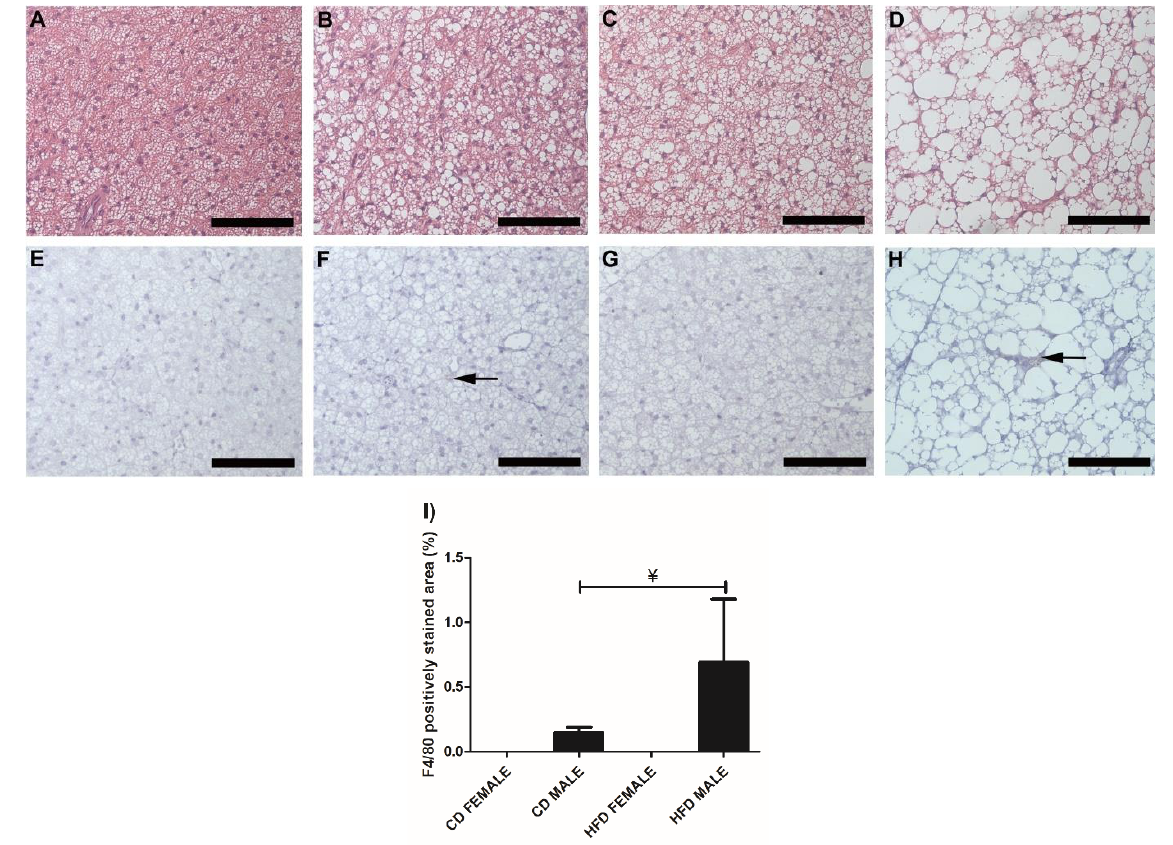
Figure 4. Histology and immunohistochemistry of BAT. Histological sections showing adipocytes in BAT of CD females, ( A ); CD males, ( B ); HFD females, ( C ); and HFD males, ( D ). Adipocyte expansion was evident in the HFD males, ( D ) and females, ( C ) compared to the CD males, ( B ) and females, ( A ). F4/80+ immunostained sections from CD females, ( E ); CD males, ( F ); HFD females, ( G ); and HFD males, ( H ). Macrophage infiltration (black arrow) was only evident in males on CD, ( F ) and HFD, ( H ) with the HFD males displaying a significantly greater extent of macrophage infiltration, ( I ). No macrophages were observed in the females on either CD, ( E ) or HFD, ( G ). ¥ Significant difference between CD male and HFD male p < 0.05. Mean ± SD. Scale bar: 100 µm.